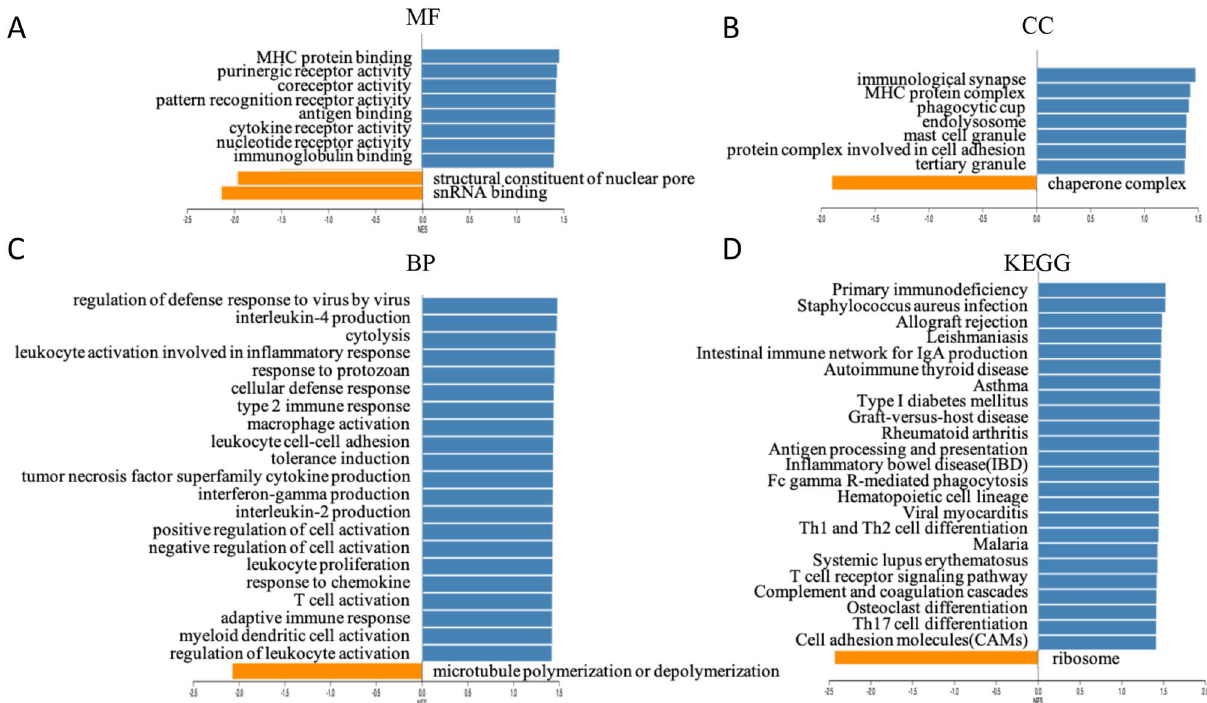
Figure 5. LCP2 -correlated genes were involved in the GO and KEGG pathways. Based on the expression of LCP2 in melanoma, GSEA analysis was performed and the enrichments of MF ( A ) CC ( B ), BP ( C ) and KEGG signaling pathways ( D ) were shown. MF molecular function, CC cellular component, BP biological